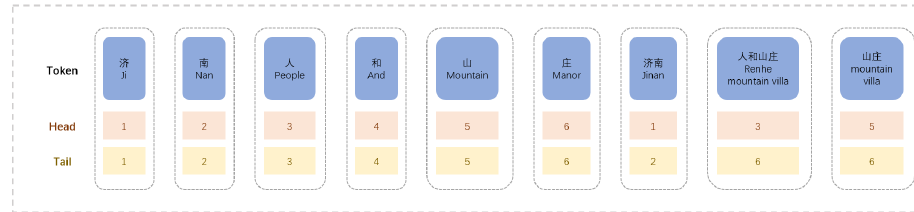
10 of 23 Figure 7. Structure diagram of Lattice. Using character vector-based models avoids word segmentation error information but lacks lexical information. For example, ‘ 感冒 (cold)’, separate the word ‘ 感 (feel)’ and ‘ 冒 (emit)’ represent different semantic information. ‘ 感 (feel)’ means feeling, and ‘ 冒 (emit)’